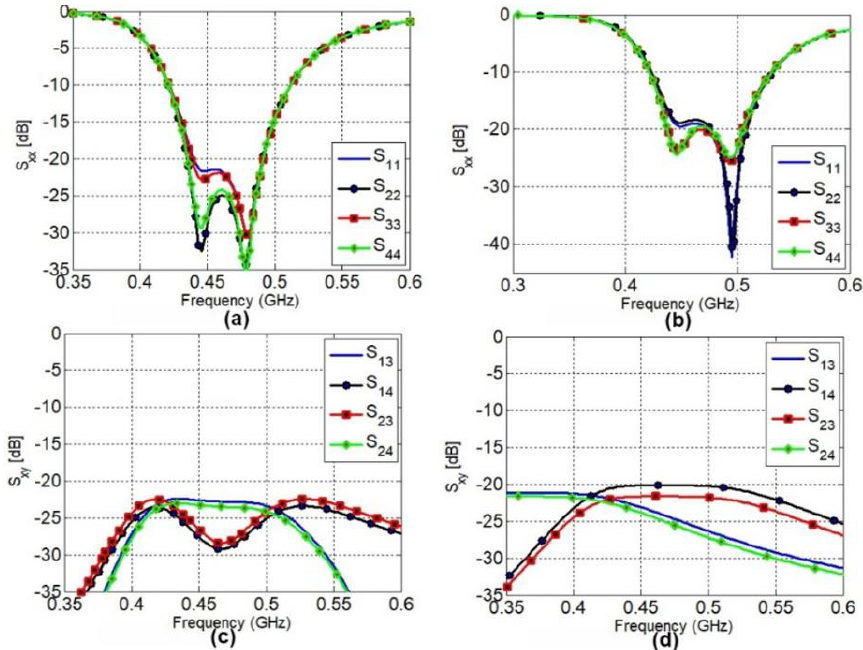
Figure 4. Proposed CubeSat MIMO antenna scattering parameters: ( a ) simulated S xx ( b ) measured S xx ( c ) simulated S xy ( d ) measured S xy .